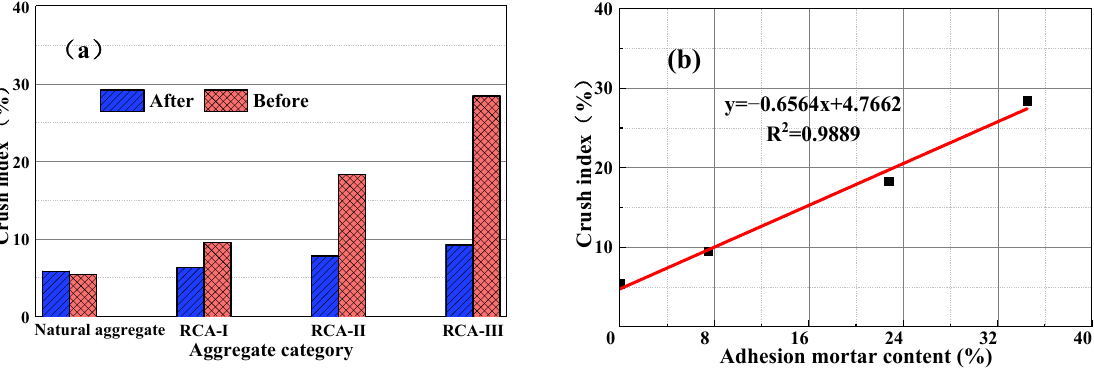
Figure 13. ( a ) The effect of calcination and grinding on the apparent density of recycled aggregate. ( b ) The relationship between the content of attached mortar and the apparent density.